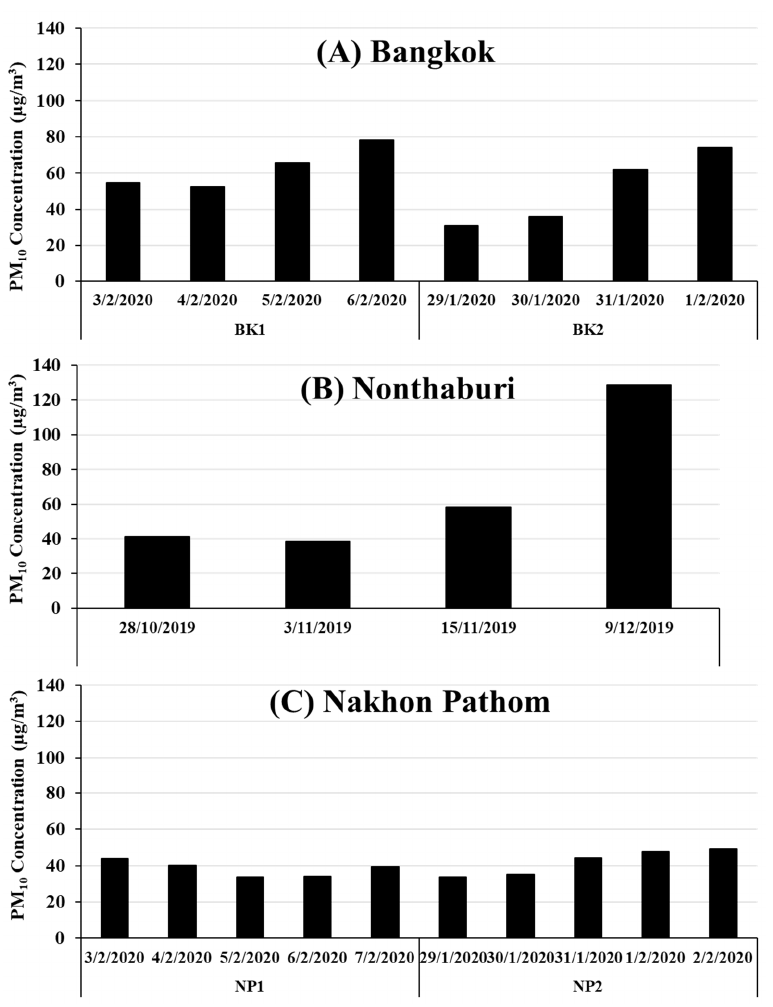
Figure 2. Ambient air concentrations of PM10 at ( A ) BK ( n = 8), ( B ) NB ( n = 4), and ( C ) NP ( n = 10).